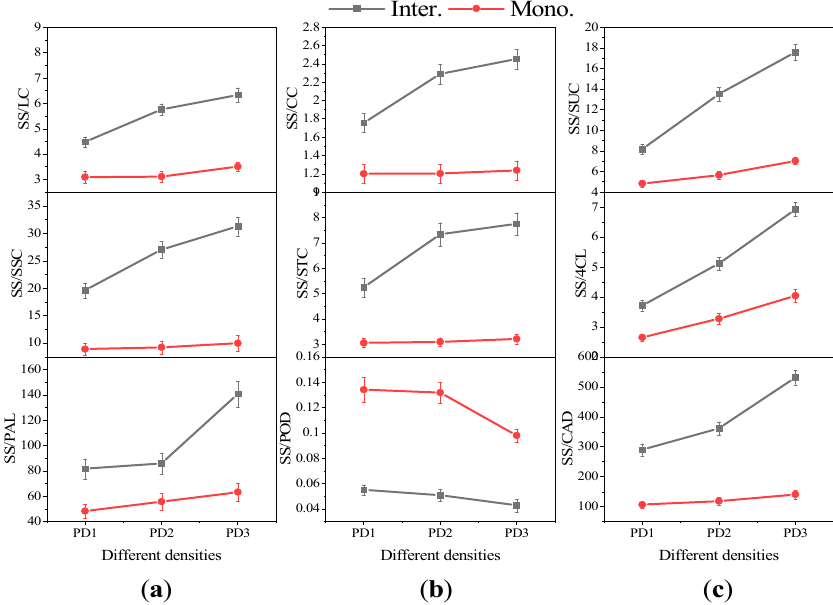
Figure 9. Contribution rate of lignin content (LC), soluble sugar content (SSC), and phenylalanine ammonia-lyase enzyme activity (PAL) ( a ); cellulose content (CC), starch content (STC), and peroxidase (POD) content ( b ); and sucrose content (SUC), 4-coumaric acid: CoA-ligase enzyme activity (4CL), and Cinnamyl alcohol dehydrogenase enzyme activity(CAD) ( c ) to stem strength (SS) under three different density treatments (PD1 = 17, PD2 = 20, and PD3 = 25 plants m − 2 ), respectively. All the values are means (±SE) standard error of three replications.